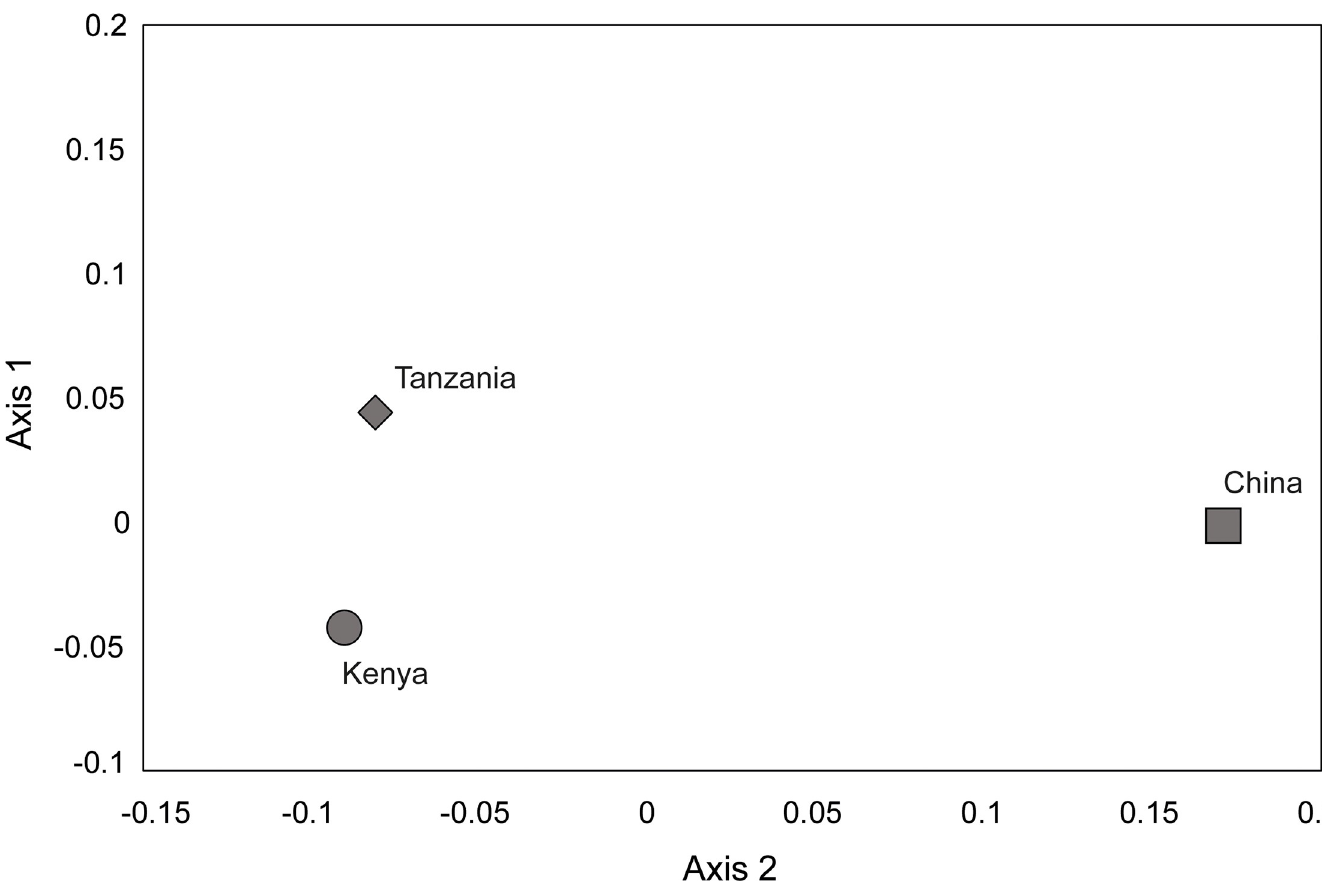
Fig 5. Two-dimensional principal coordinate analyses plot of the beta diversity of bacterial genera in Diaphorina citri collected from different countries, estimated using the Bray Curtis dissimilarity index showing.